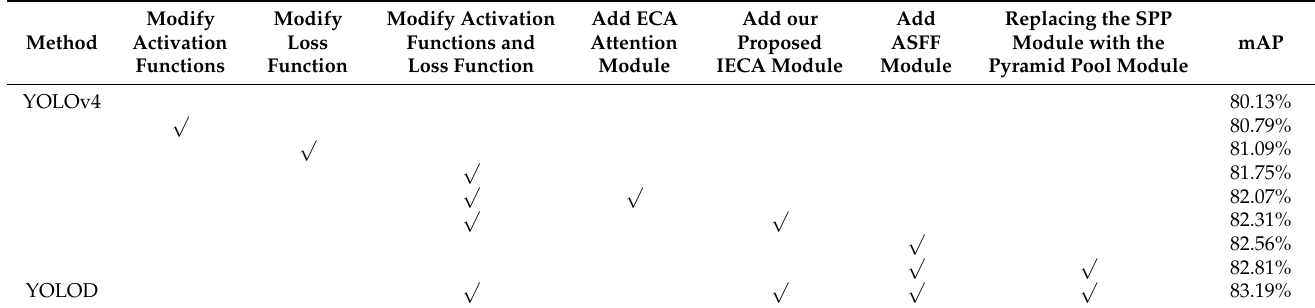
Table 4. Results of ablation